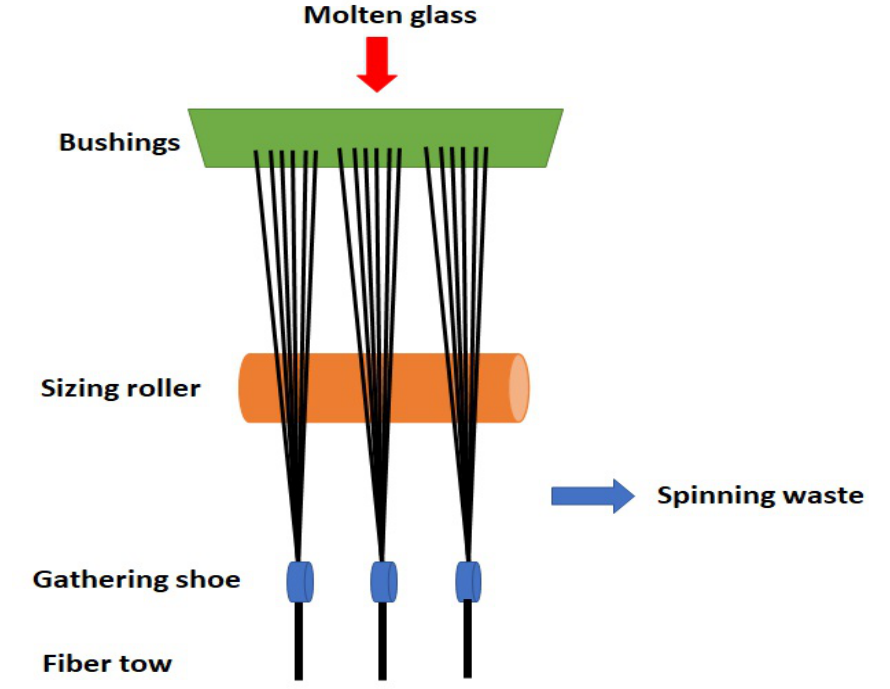
Figure 1. A schematic of glass fiber production line.